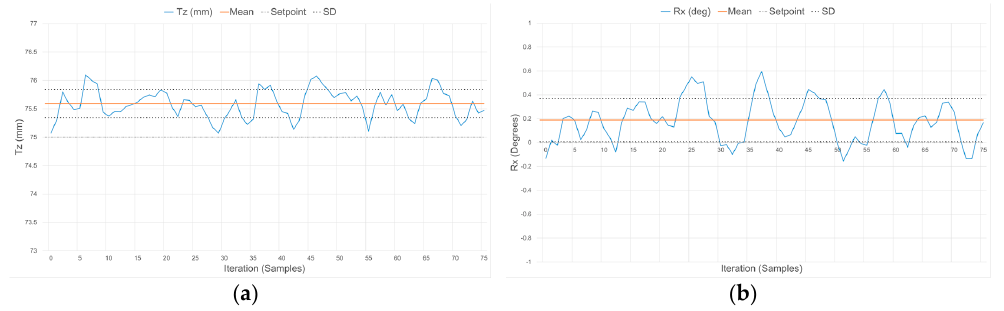
Figure 24. Response of the compliant wrist operating in proximity mode while measuring: ( a ) distance to; and ( b ) relative orientation of a fixed planar surface placed at 75 mm in front of the wrist and perpendicular to its main aiming direction (0°).